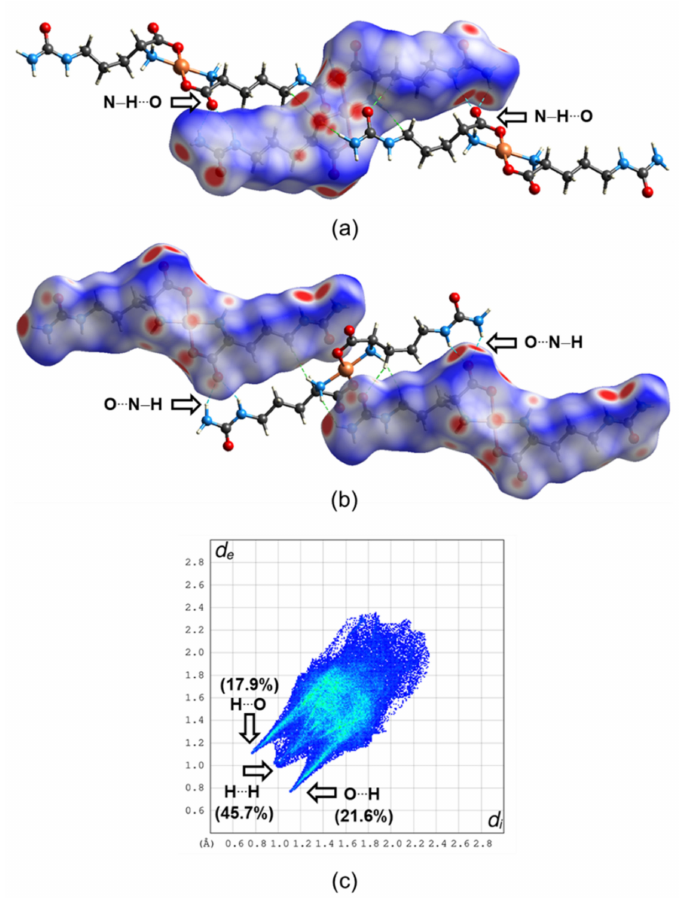
Figure 12. Hirshfeld surfaces mapped with d norm parameter of [Cu(Citr) 2 ] n in two equivalent surfaces: ( a ) Citr1 and Citr2 inside the HS with Citr3–Citr4 acting as ligands outside the HS, ( b ) the Citr3–Citr5 and Citr4–Citr6 inside the HS with Citr1 and Citr2 outside the HS, and ( c ) 2D-fingerprint plot of non-covalent